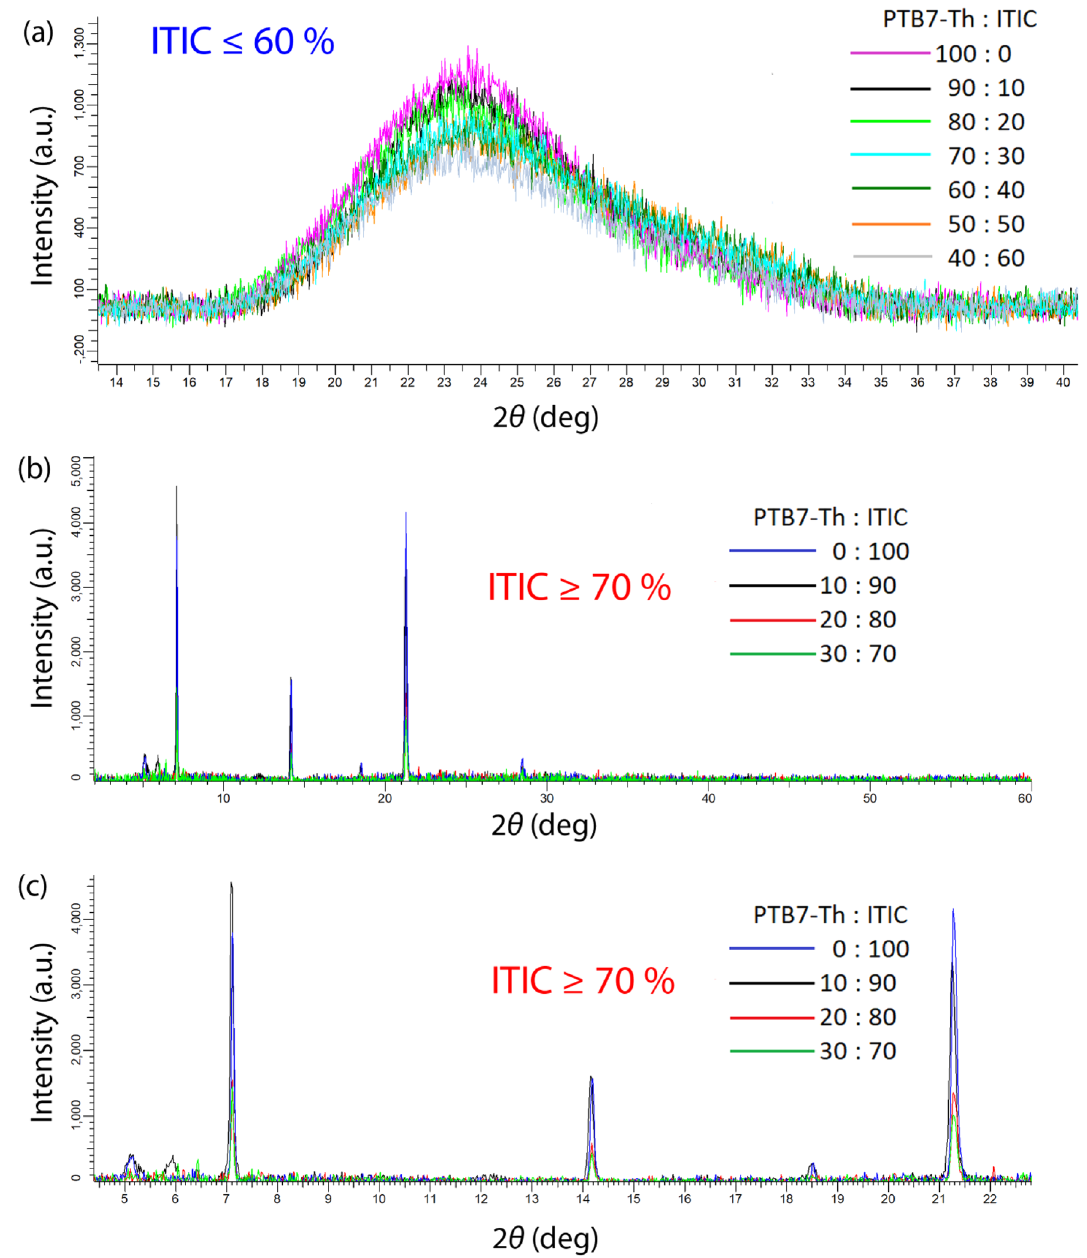
Figure 7. XRD patterns of PTB7-Th:ITIC films as a function of weight ratio. ( a ) PTB7-Th:ITIC = 100:0, 90:10, 80:20, 70:30, 60:40, 50:50 and 40:60. ( b ) PTB7-Th:ITIC = 30:70, 20:80, 10:90, and 0:100. ( c ) Magnified XRD pattern when PTB7-Th:ITIC = 30:70, 20:80, 10:90, and 0:100.